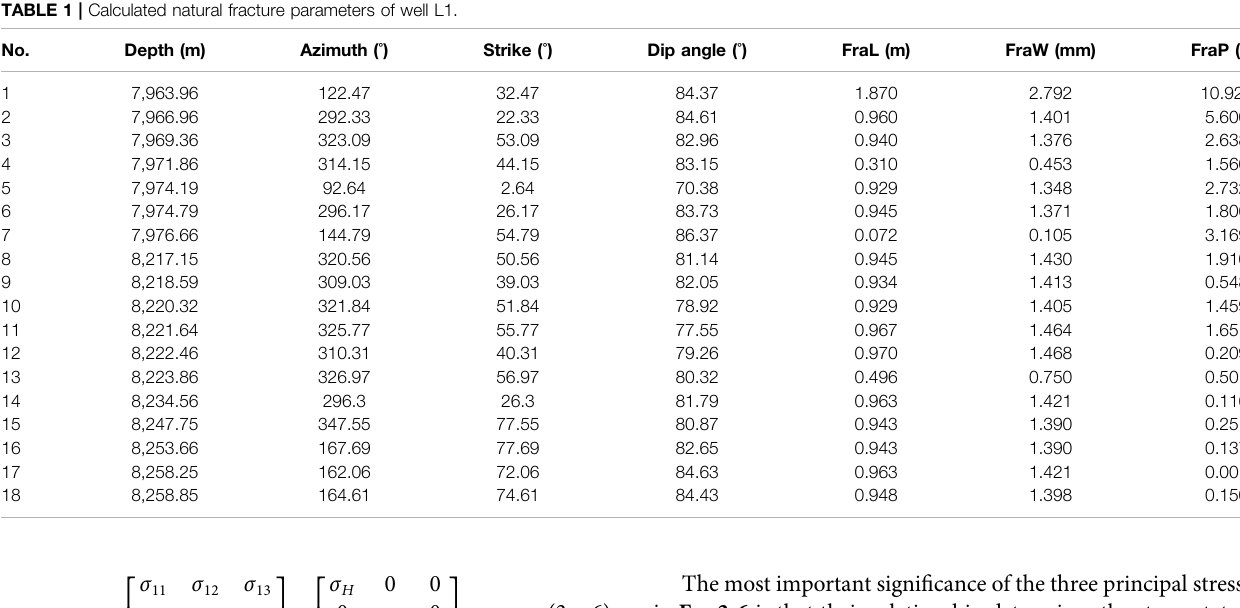
TABLE 1 | Calculated natural fracture parameters of well